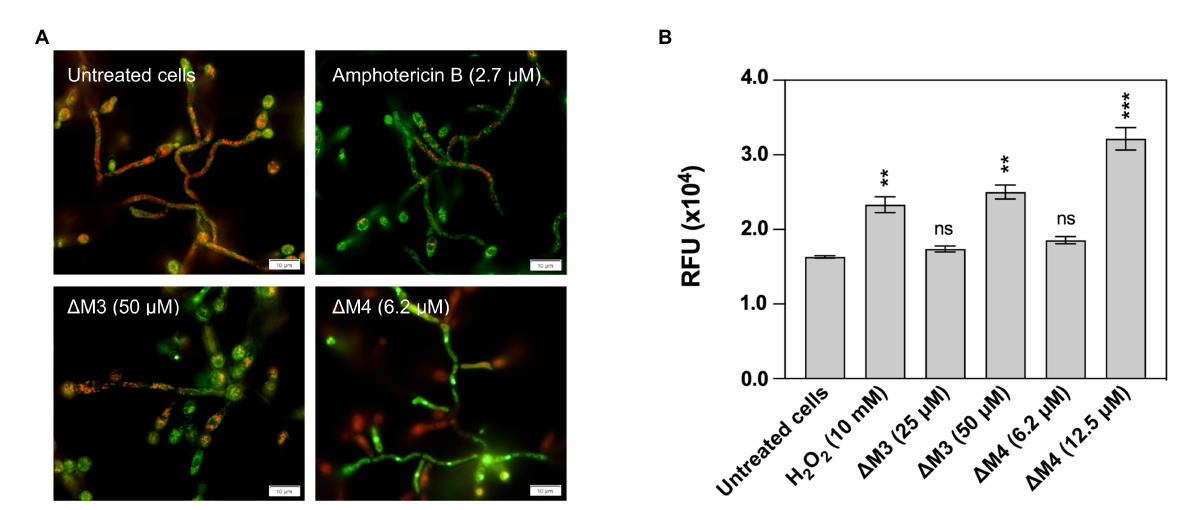
FIGURE 8 Induction of mitochondria activation and increased intracellular Ca 2+ concentration by Δ M3 and Δ M4. (A) The changes in mitochondrial activity after treatment with peptides were detected in 24-h biofilms of C. albicans. Cells were incubated with 50 μ M Δ M3, 6.2 μ M Δ M4 or 2.7 μ M amphotericin B for 3 h. Changes in mitochondrial activity and the entire mitochondrial pool was determined with 0.5 μ M Mitotracker Orange and 0.5 μ M Mitotracker Green, respectively. Representative images of microscope analysis performed with the Olympus IX73 microscope for each sample are presented. (B) To detect intracellular Ca 2+ , 24-h biofilms of C. albicans were incubated with Δ M3 (25 μ M and 50 μ M), Δ M4 (6.2 μ M and 12.5 μ M) or H 2 O 2 (10 mM, positive control) for 3 h. Next the Fura-2 Calcium Flux Assay Kit was performed according to the manufacturer’s instructions. The bars represent the values of mean ± SD ( n = 3), RFU – relative fluorescence unit. Statistical analysis was performed with one-way